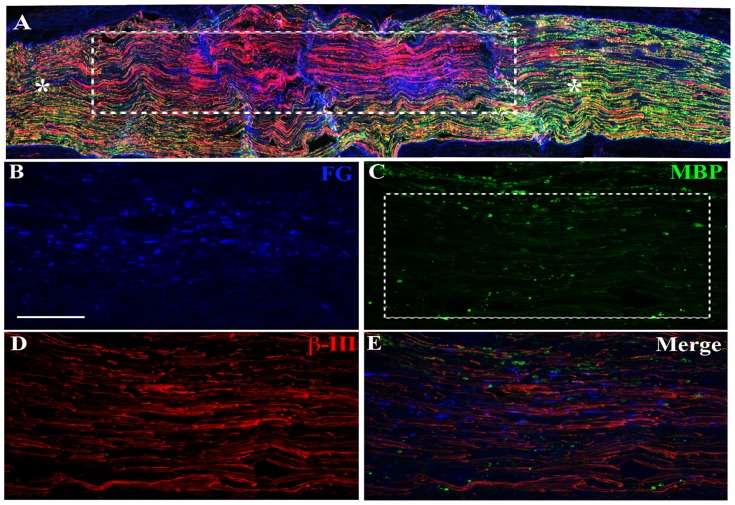
FluoroGold (FG) staining delineates the demyelination zone.Representative fluorescence photomicrographs from a longitudinal section of tibial nerve six days after injection with a lysophosphatidyl choline (LPC)/FG mixture and doubly immunostained for myelin basic protein (MBP; green, C) and β-III tubulin (red, D). Note: FG was taken up by cells in the injection site region and diffused beyond the injection site. There was good register between the most intensely stained region of FG (blue, A, E) and the area of demyelination as defined by the punctate immunostaining for MBP and a lack of the normally uniform linear MBP staining (A, C). The presence of positive linear β-III tubulin IF indicates that axons within the demyelination site persist (A, D). The demyelination site was identified by the joint presence of FG, axonal (β-III tubulin) and paucity of myelin marker (MBP) (boxed areas A, E) in contrast to the robust MBP immunostaining outside the zone of demyelination (asterisks, A). Thus, FG serves to identify the regions of interest (ROIs; similar to that outlined by dashed lines in (C)), where alterations in various markers impacted by the LPC and electrical stimulation were quantified (see Figures 2, 4, 5, 7). Scale bar = 100 µm.